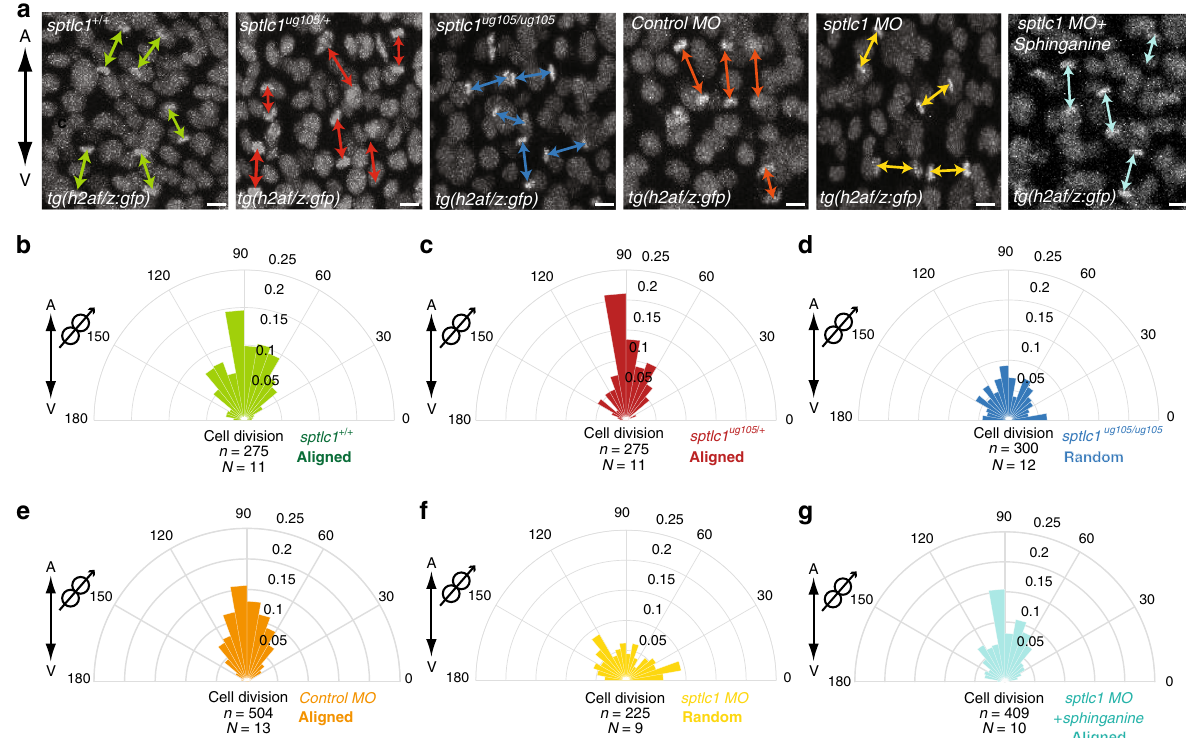
Fig. 4 Sphingolipids regulate oriented divisions of epiblast cells. a – g Orientation of division of dorsal epiblast cells with respect to the A/V embryonic axis determined by using H2A.F/Z:GFP transgenic line to monitor chromosome separation during anaphase. a Representative confocal images of dorsal epiblast cells expressing H2A-GFP in sptlc1 + / + , sptlc1 ug105/ + and sptlc1 ug105/ug105 embryos and in control, sptlc1 morphants and sptlc1 morphant embryos treated with sphinganine (from left to right) from at least nine independent experiments. Division axes are marked by arrows. Animal pole is up. Scale bars: 10 µ m. b – g Polar graphs showing the frequency distribution of the angle between the division axis and the A/V embryonic axis from ( a ) in sptlc1 + / + , ( b ) sptlc1 ug105/ + , ( c ) sptlc1 ug105/ug105 , ( d ) control morphants, ( e ) sptlc1 morphants, ( f ) and sptlc1 morphants treated with sphinganine ( g ). n (number of cell divisions analyzed) over N (number of embryos). Divisions are aligned along the A/V axis in sptlc1 + / + , sptlc1 ug105/ + and in control morphant embryos, but randomized in sptlc1 ug105/ug105 embryos and sptlc1 morphants. Randomization of division in sptlc1 morphants is rescued by injection of 0.5 nl of 0.25 μ M sphinganine. In ( b – g ), χ 2 test was used (see Supplementary Table 1). Cartoons at the corner of polar graphs in this report indicate the parameter measured. Source data are provided as a Source Data fi